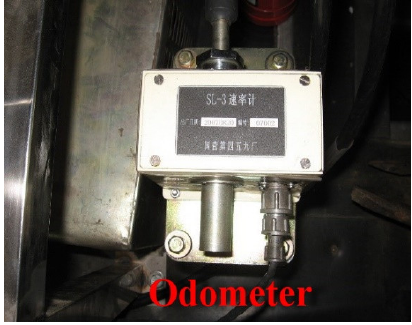
Figure 4. The real picture of the strapdown inertial navigation system (SINS).